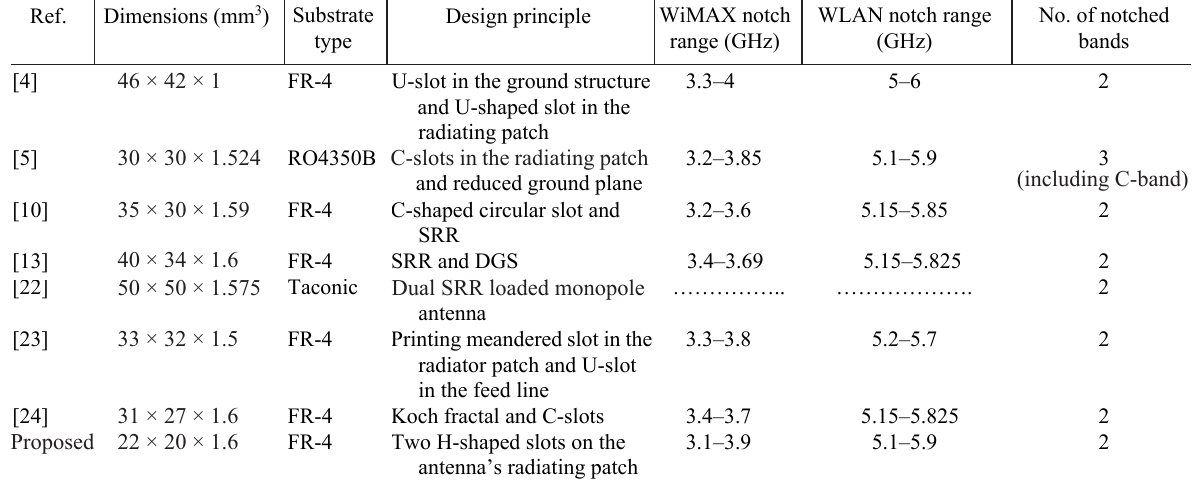
Table 1. Comparison between the suggested antenna and other reported antennas in [4,5,10,13,22–24]